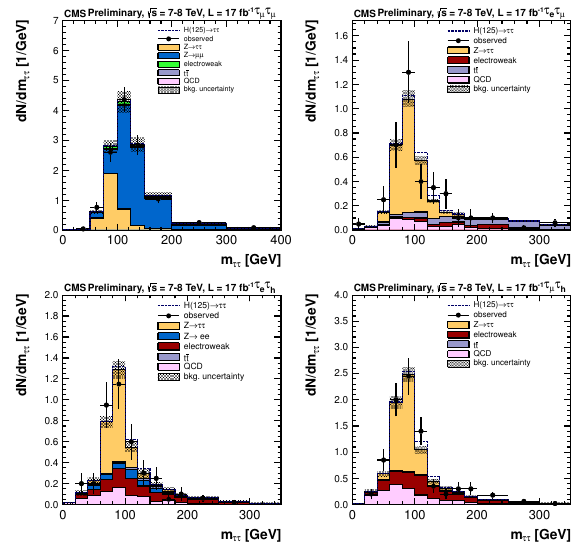
Figure 1. Fully reconstructed invariant mass of the di- τ system in the 1-Jet high τ p T event category. Shown are invariant mass distributions of the (upper left) µµ + X , (upper right) e µ + X , (lower left) e τ h + X , and (lower right) µτ h + X decay channel. The fully reconstructed invariant mass of the di- τ system in the 1-Jet event category in the τ h τ h + X decay channel is shown in figure 3 (left).